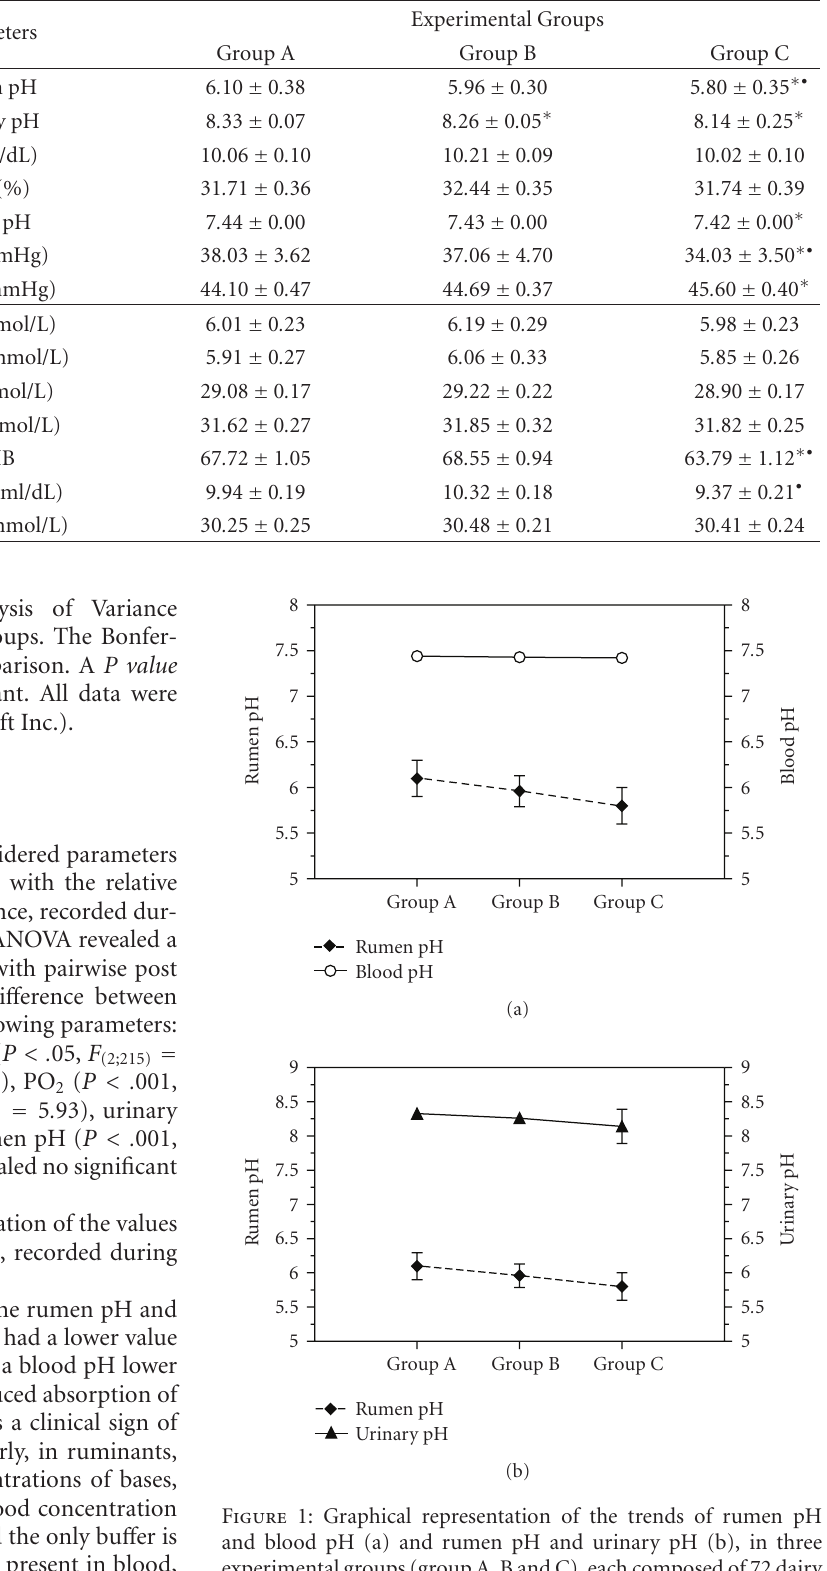
Table 2: Mean values ( ± SD) of haematological parameters in dairy cows of Groups A, B, and C, each composed of 72 dairy cows. Significant di ff erences between group C and the other two groups are indicated by ∗ (vs group A, P < . 05) and • (vs group B, P < . 001).